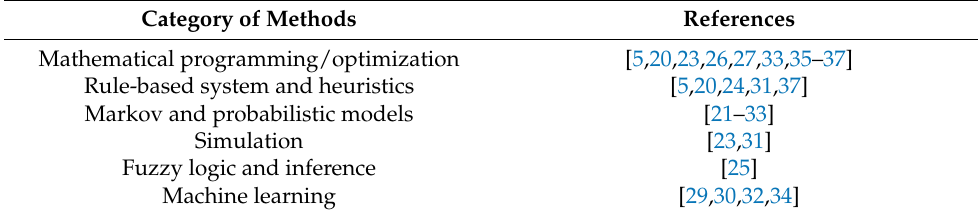
Table 5. Methods for cost estimation and maintenance planning.